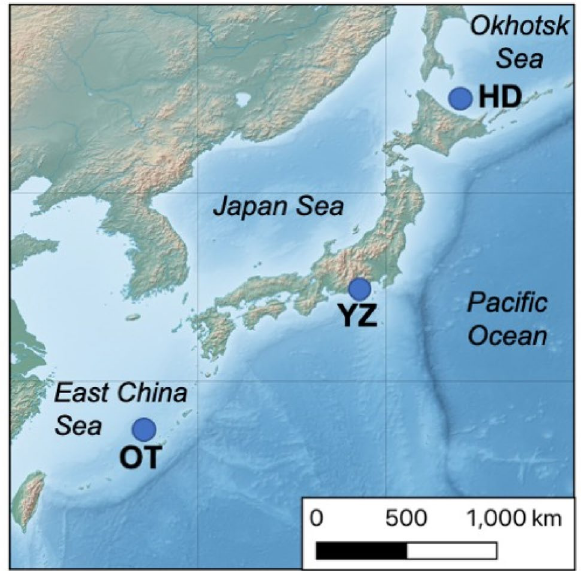
Figure 1. Map showing sampling sites off of Japan. OT = Okinawa Trough, YZ = Suruga Bay, and HD = offshore Hokkaido. This map was made with Natural Earth (free vector and raster map data, https:// www. natur